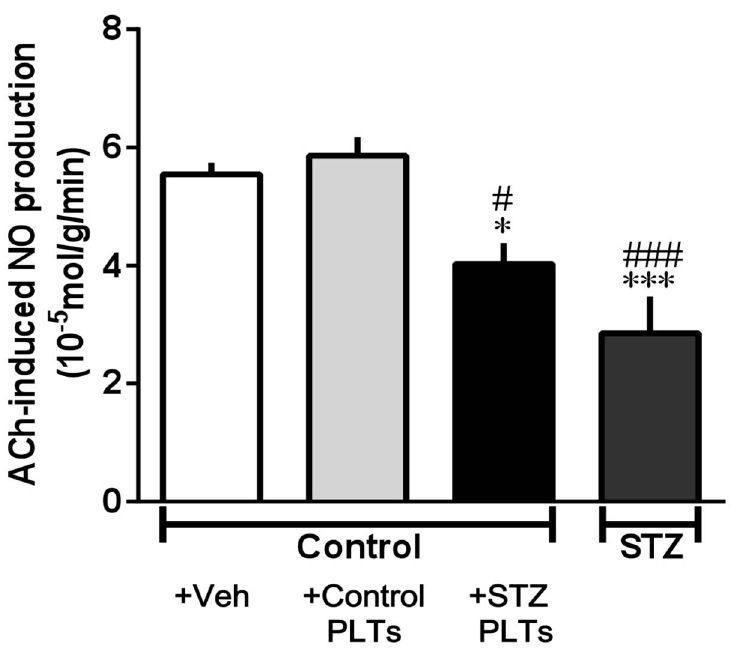
Figure 3. Release of NOx under ACh stimulation in carotid arteries. Control carotid arteries were incubated for 30 min at 37 u C with 1.65 6 10 7 cells/mL of control or STZ PLTs before this experiment. The release of NOx in each treated or untreated carotid artery from control or diabetic rats with ACh (10 2 6 M) stimulation. Data are means 6 SE; n=5–6. *P , 0.05 or ***P , 0.001 vs. Control + Veh (only ACh-treated carotid arteries from control). # P , 0.05, ## P , 0.01, or ### P , 0.001 vs. Control + Control PLTs.